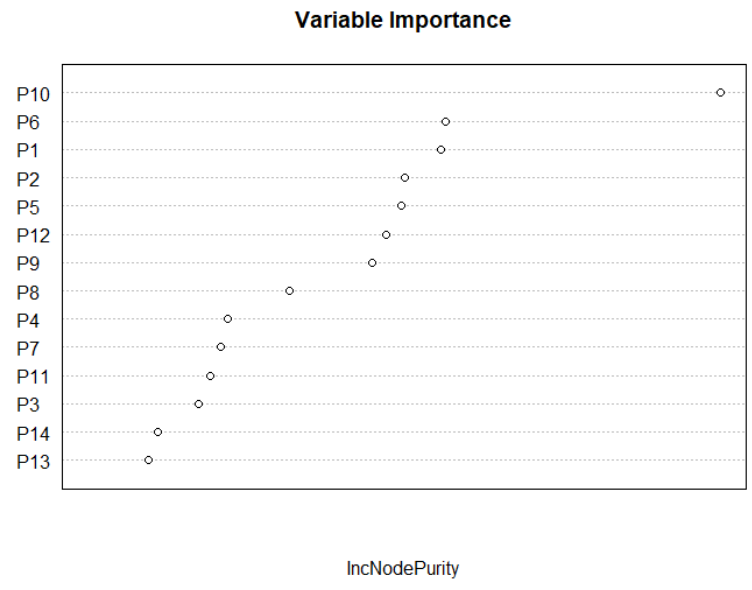
Figure 6. Variable Importance in the random forest model.